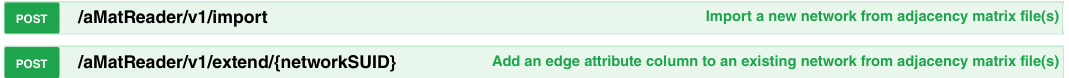
Figure 2. Functions exposed by the aMatReader API, as documented in